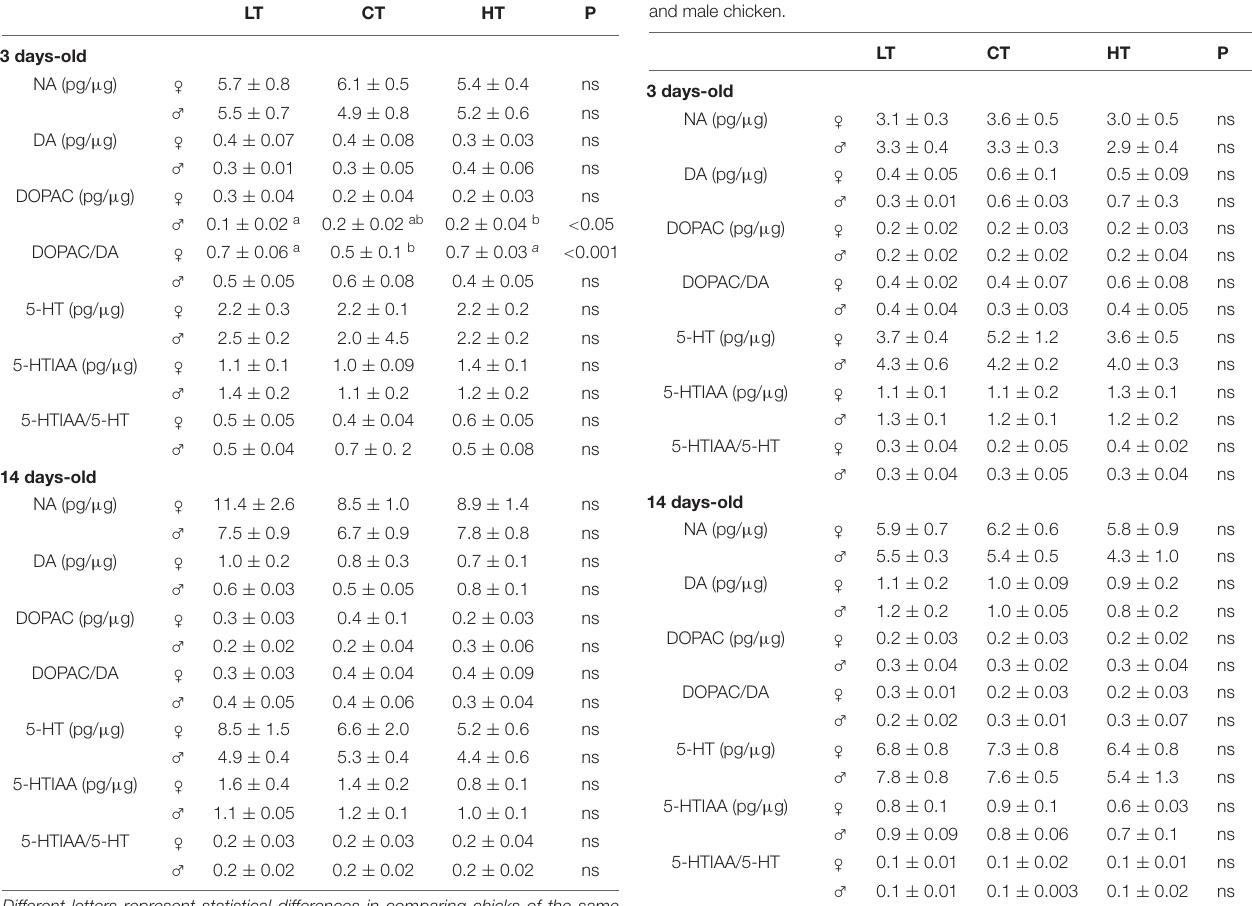
TABLE 4 | Effects of low (LT), control (CT), and high (HT) temperature of incubation on noradrenaline (NA), dopamine (DA), 3,4-dihydroxyphenylacetic acid (DOPAC), TABLE 5 | Effects of low (LT), control (CT), and high (HT) temperature of